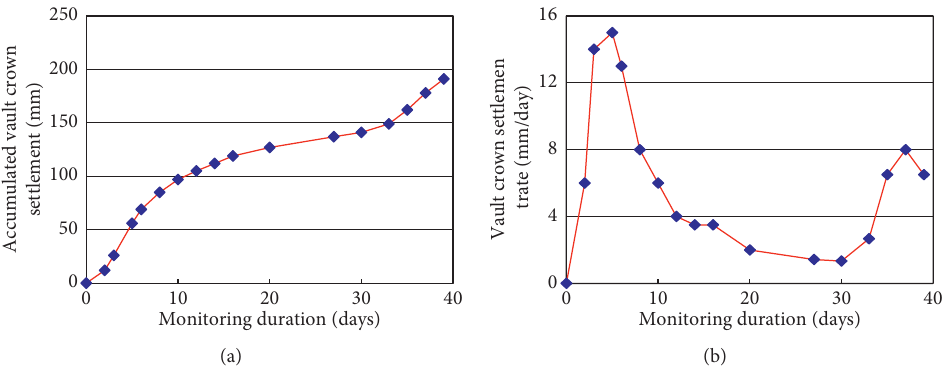
Figure 1: Vault crown settlement of the right tube at the stake of YK61+810 in Huangjiazhai Tunnel: (a) accumulated vault crown settlement with monitoring duration; (b) vault crown settlement rate with monitoring duration.